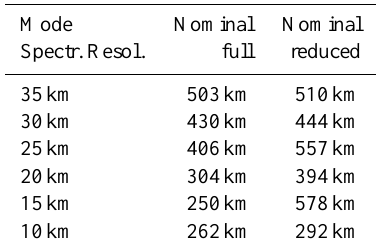
Table 8. Horizontal information smearing (full width at half maxi- mum of the horizontal component of the 2-D averaging kernel) for CFC-12.